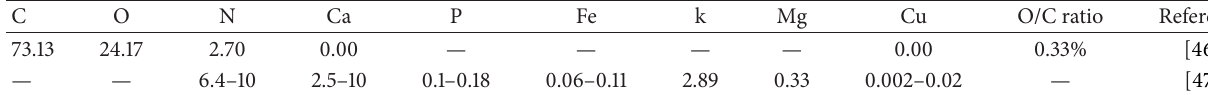
Table 5: Elemental composition of pineapple plant.